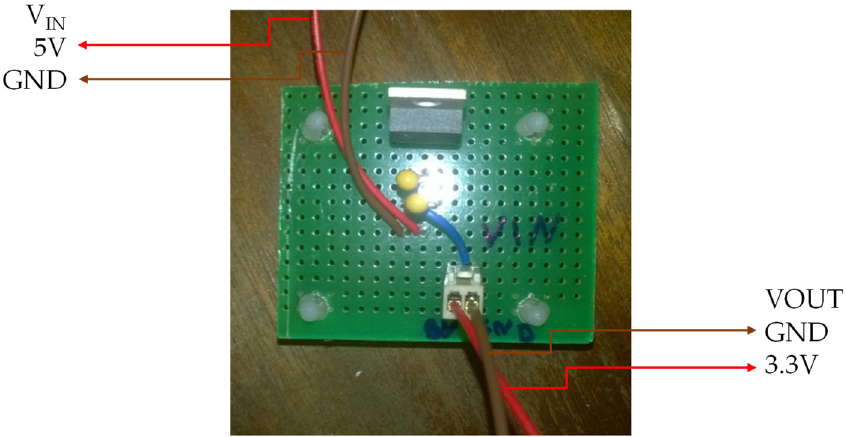
Figure 21. PCB board with an electric circuit for 5 V to 3.3 V conversion through the LM1117T-3.3 voltage regulator.